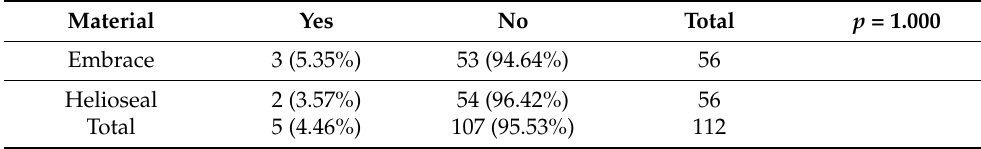
Table 7. Assessment of carious lesion after 18